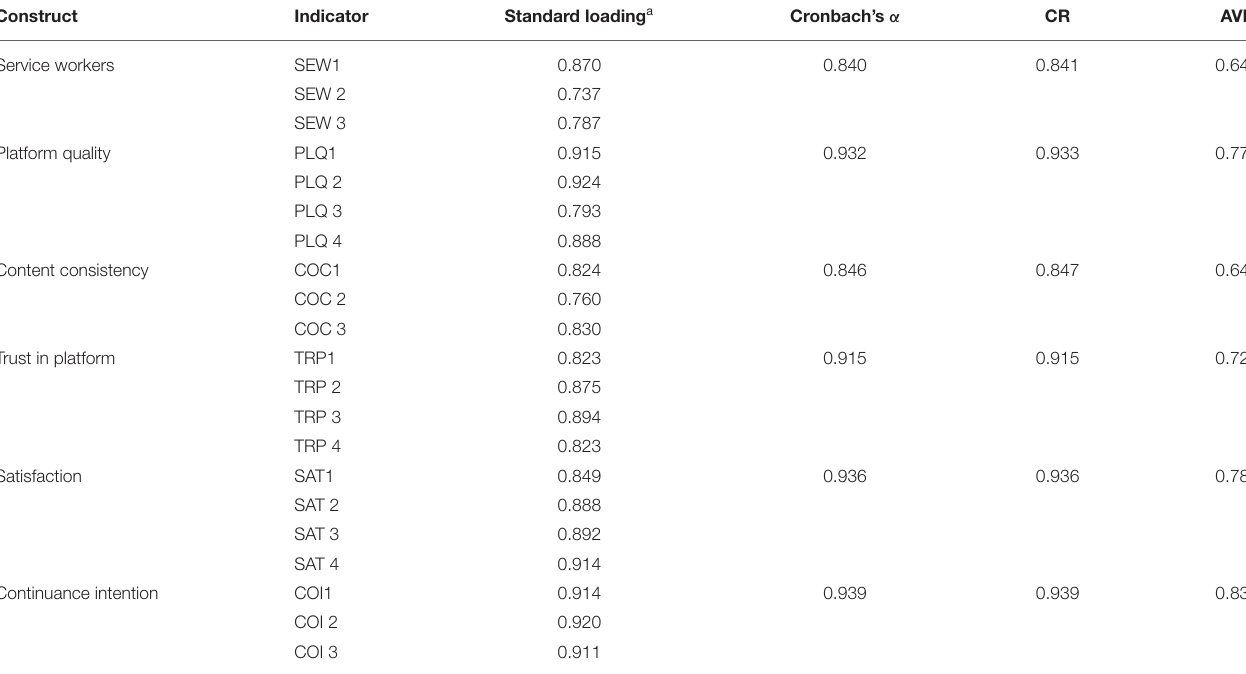
TABLE 2 | Results of confirmatory factor analysis.